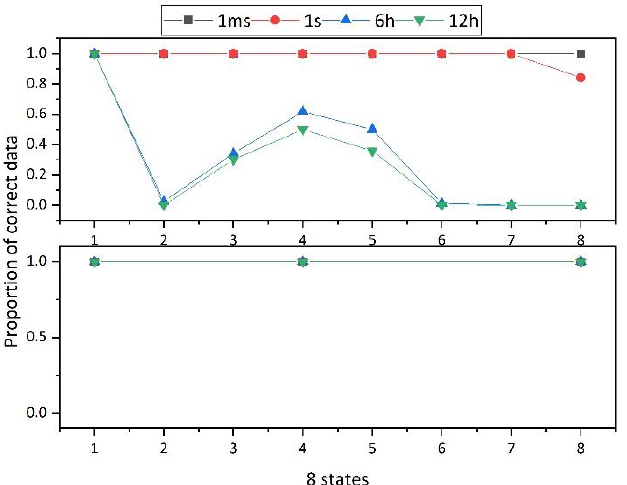
Figure 12. Comparison of the likelihood of reading the correct data between conventional 1T1R and the proposed 2T2R structure.